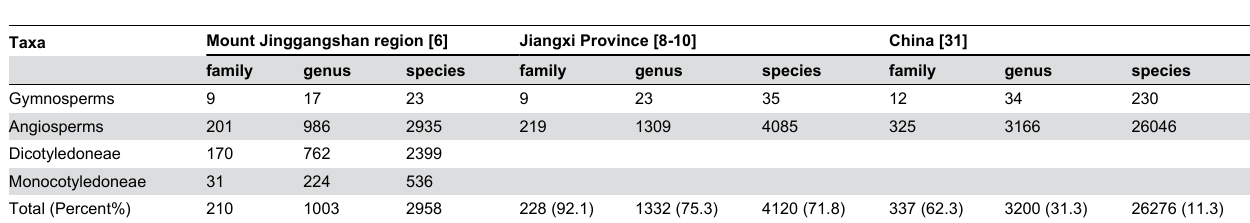
Table 2. Composition of the seed plant flora of Mount Jinggangshan